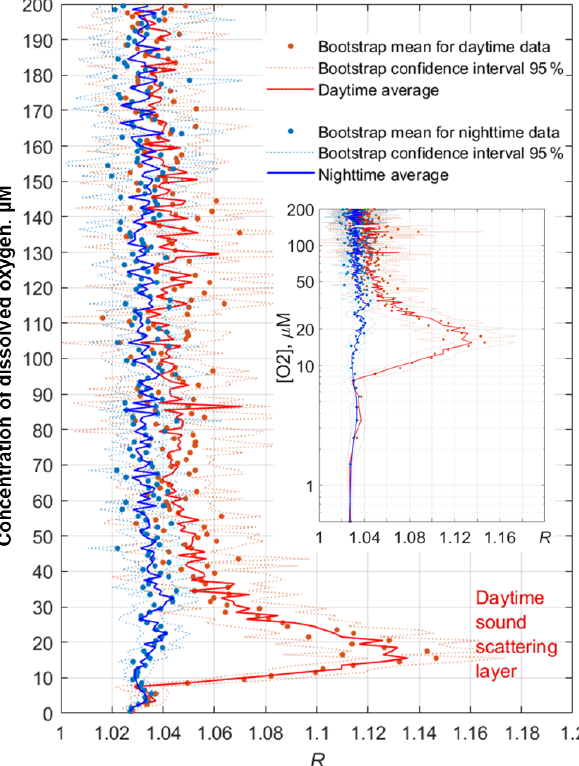
Figure 13. Example profiles of the daytime and nighttime averages (cid:104) R( [ O ] ) (cid:105) in November 2019. The inset shows the same plots with 2 the y axis drawn logarithmically to reflect the lower parts of the profiles (the hypoxic zone) in more